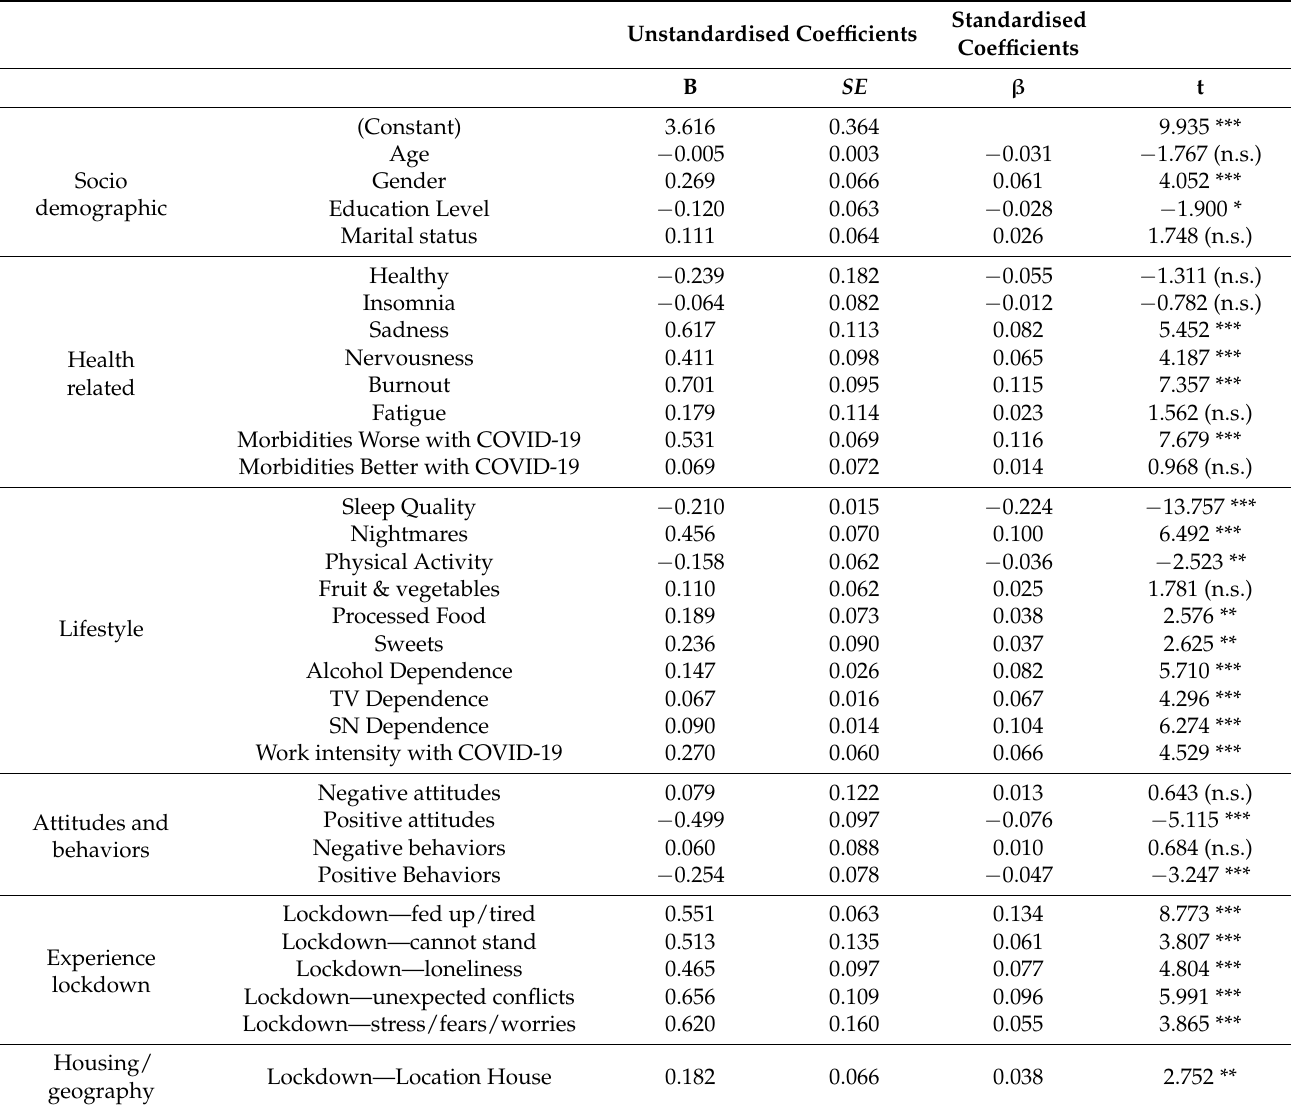
Table 2. Linear regression—dependent variable Calamity Experience